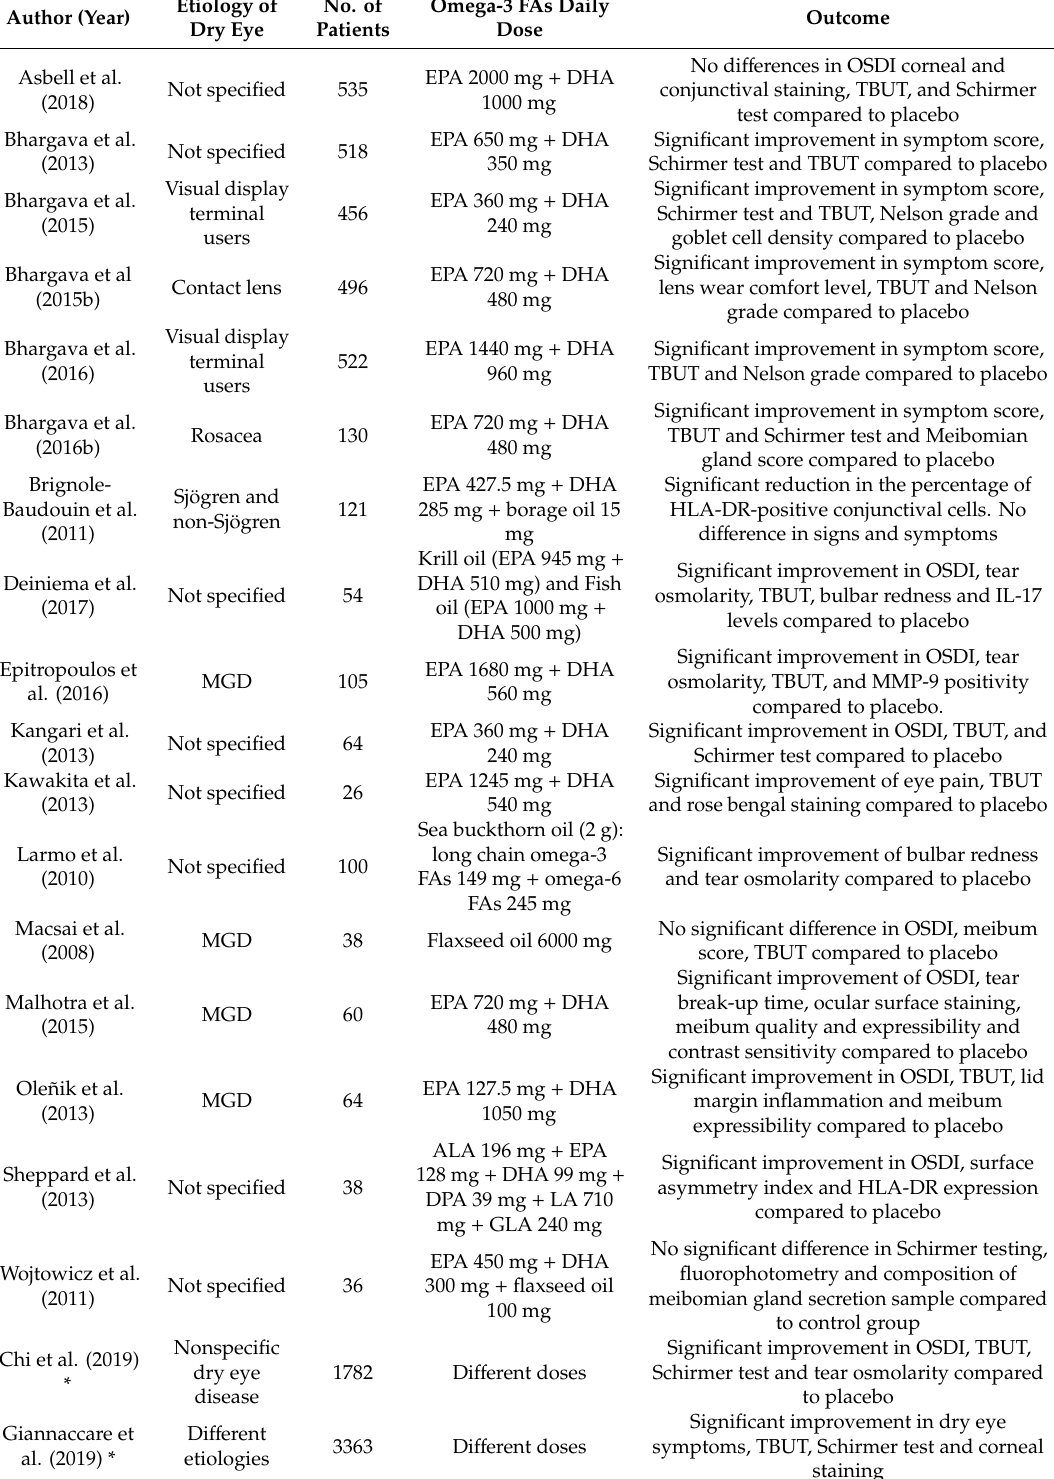
Table 1. Characteristics of high level of evidence studies (randomized controlled trials and meta-analyses) evaluating the e ffi cacy of omega-3 fatty acids in dry eye